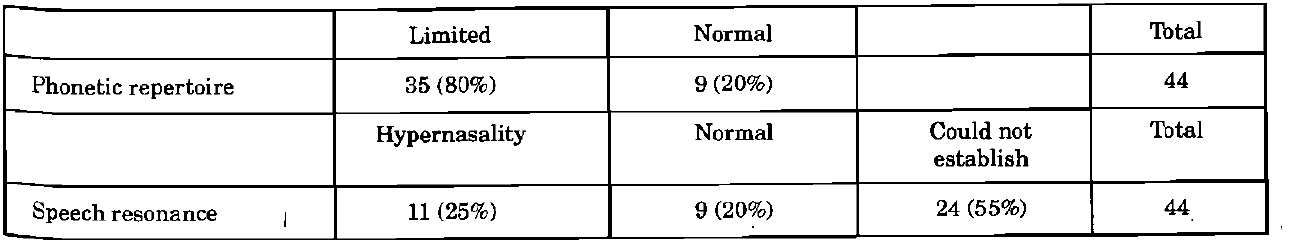
TABLE 3. Prespeech Development,